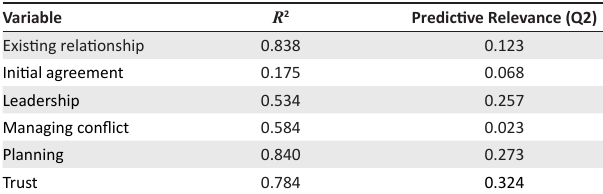
TABLE 3: Evaluation of structural